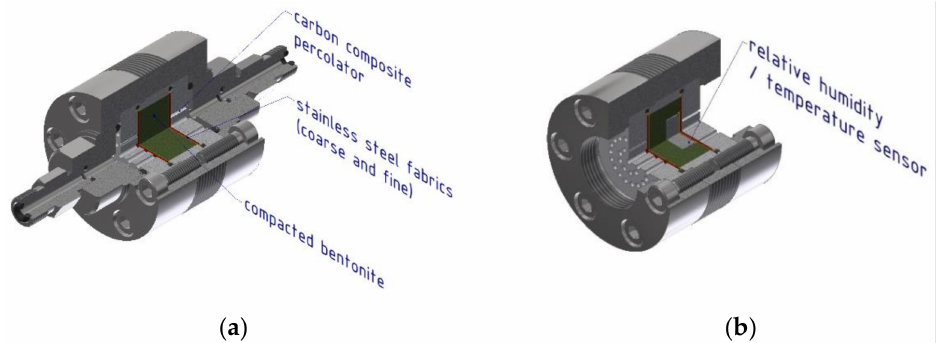
Figure 2. Experimental cell set-up for measuring ( a ) saturated hydraulic conductivity and ( b ) water retention